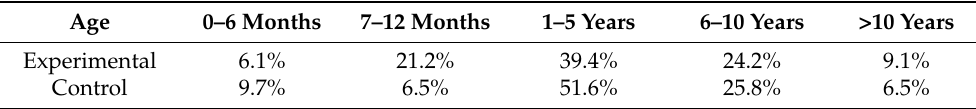
Table 5. Age of female dogs (experimental and control) at